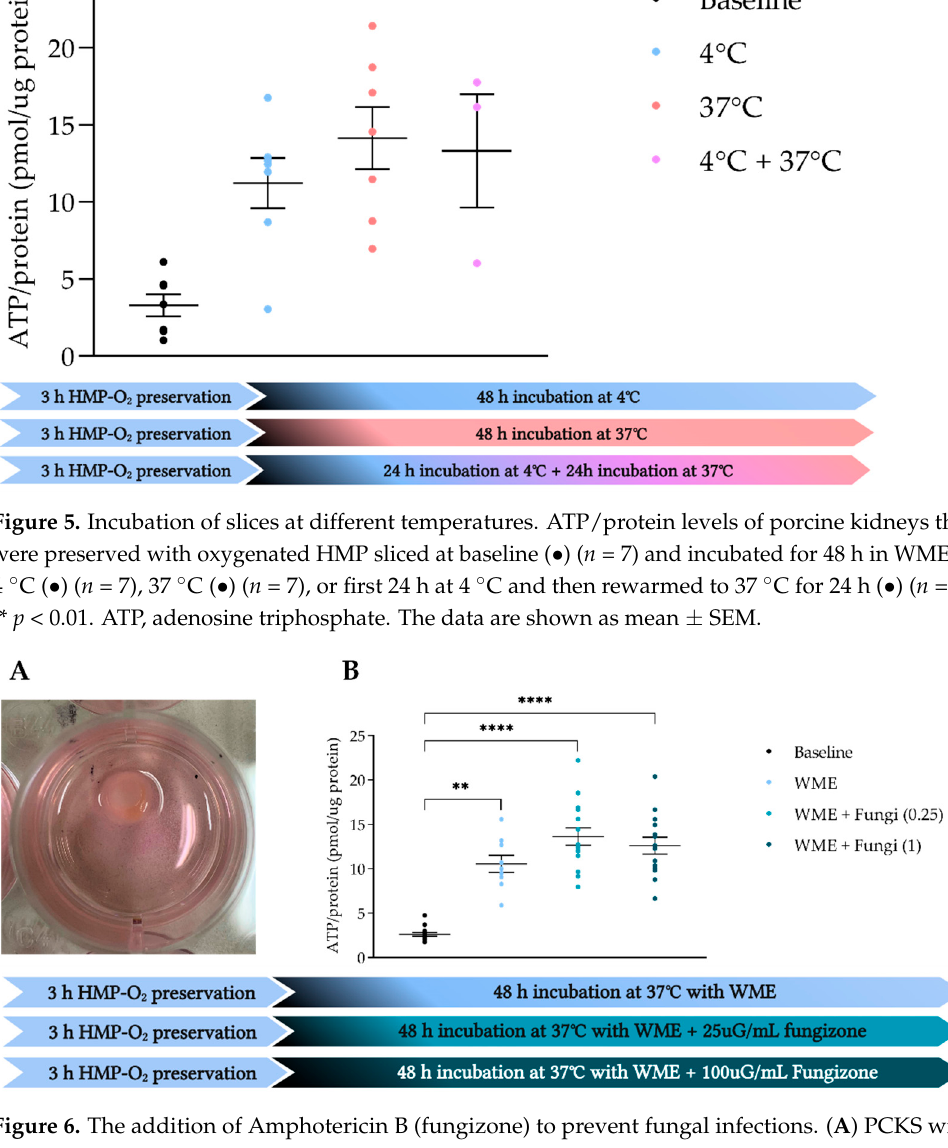
Figure 5. Incubation of slices at different temperatures. ATP/protein levels of porcine kidneys that were preserved with oxygenated HMP sliced at baseline ( ● ) ( n = 7) and incubated for 48 h in WME at 4 °C ( ● ) ( n = 7), 37 °C ( ● ) ( n = 7), or first 24 h at 4 °C and then rewarmed to 37 °C for 24 h ( ● ) ( n = 3). ** p < 0.01. ATP, adenosine triphosphate. The data are shown as mean ± SEM.